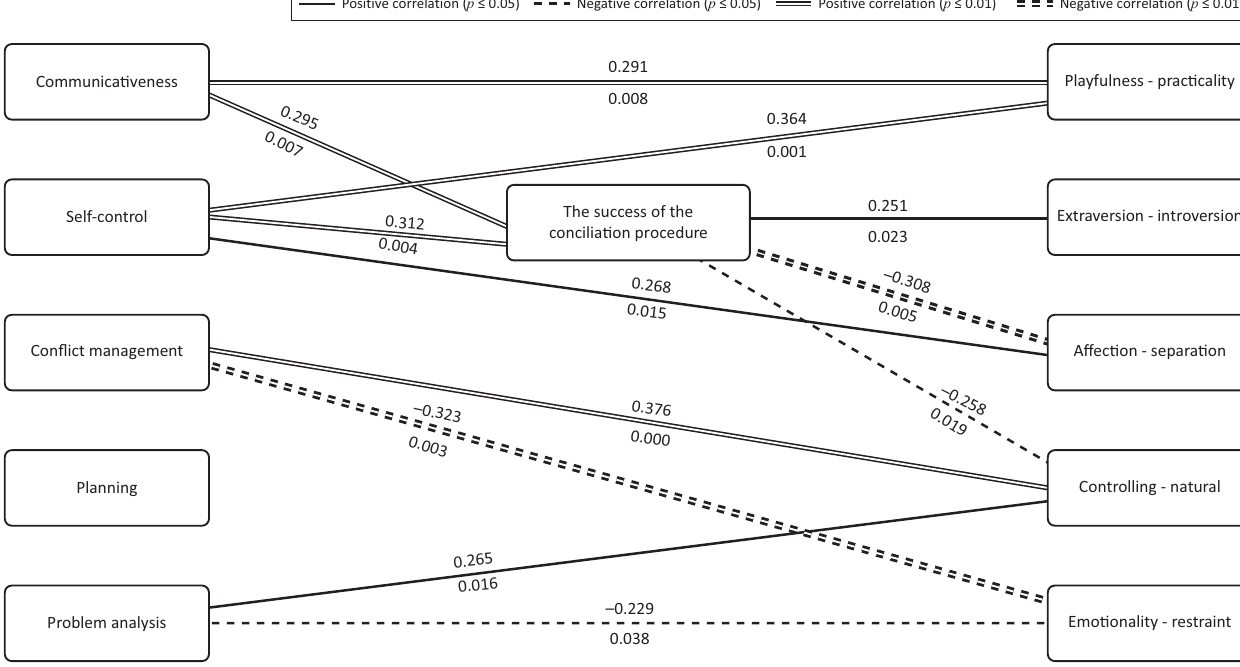
Communica(cid:23)veness